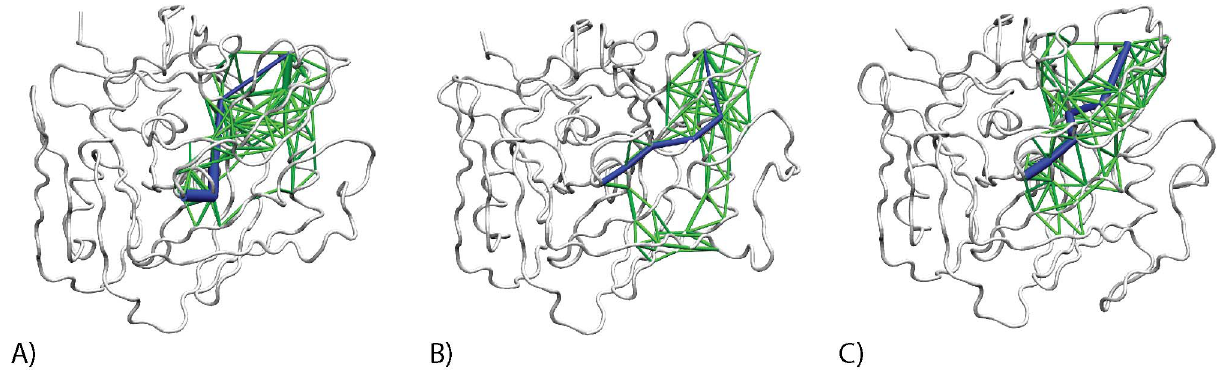
Figure 4. The optimal (blue) and suboptimal paths (green) for communication from the CD4 binding loop to the C-terminus end of the a 2 helix for the (A) YU2 (B) HXB2 and (C) CAP210 networks.